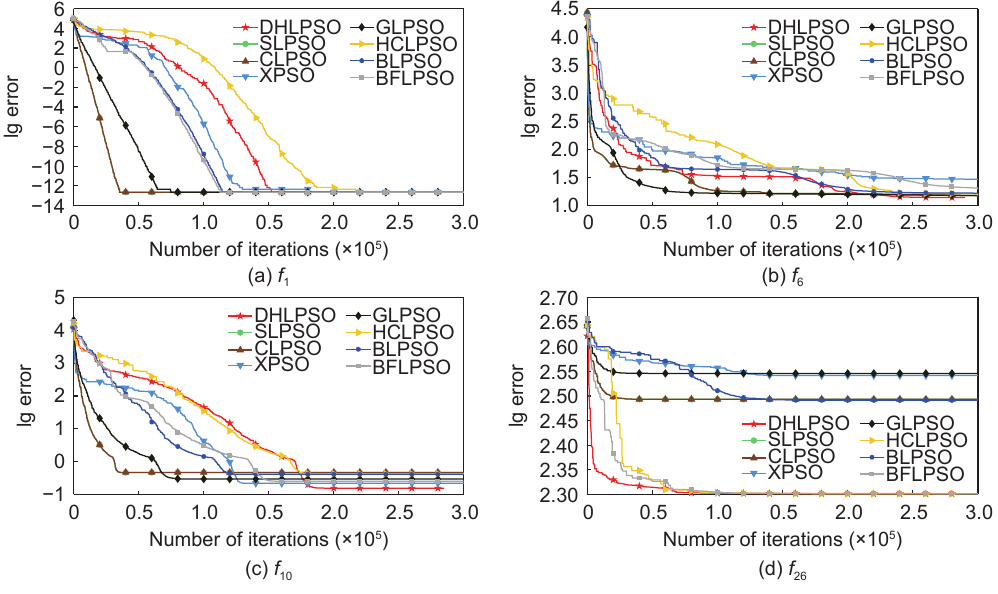
Fig. 6 Convergence curves of the eight comparison